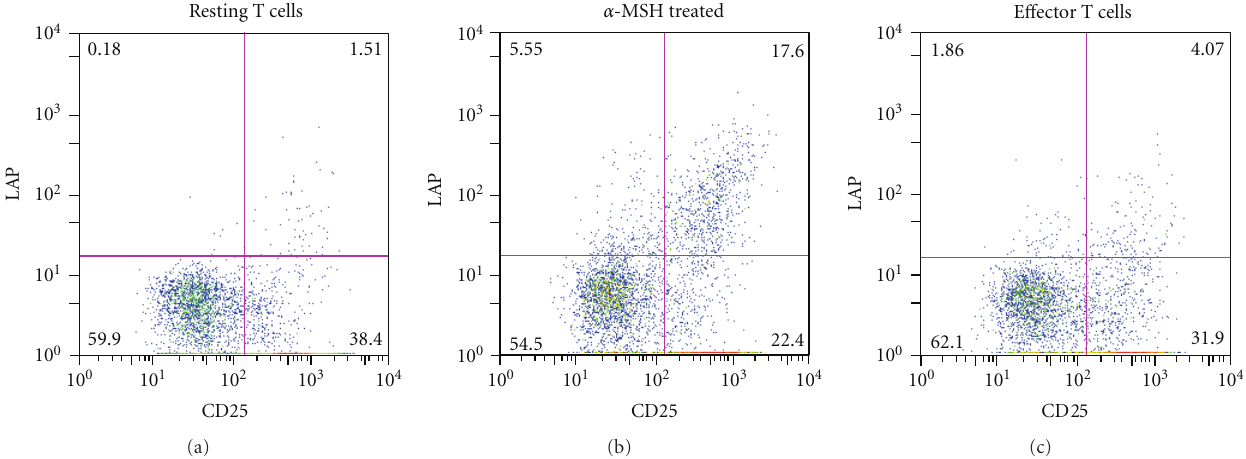
Figure 2: Flow cytometry analysis of LAP expression on α -MSH-induced Treg cells. The T cells were collected and treated as in Figure 1, but were costained for CD25 and LAP. The flow cytometry results are presented as dot plots showing T cells expressing CD25 and LAP representing the results of two independent experiments. The expression of LAP on the e ff ector T cells decreases relative to the resting T cells. In contrast, there is more than a 10-fold increase in LAP expression on α -MSH-induced Treg cells compared to the e ff ector T cells.